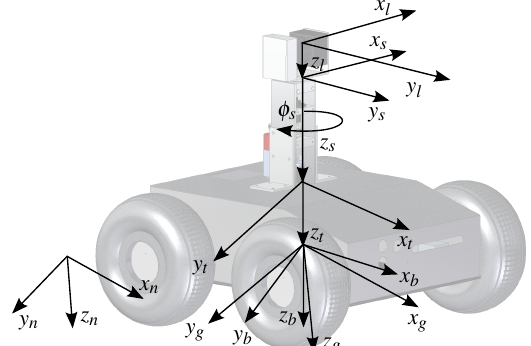
Figure 4: Overview of the different used coordinate systems